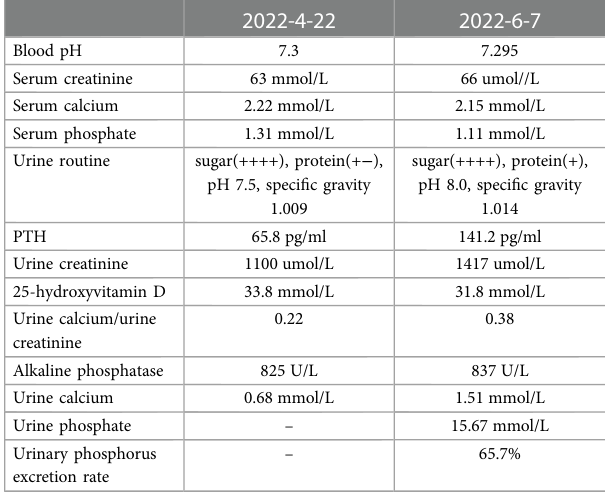
IgG and C3, but other immunoglobulins and lymphocyte subsets were